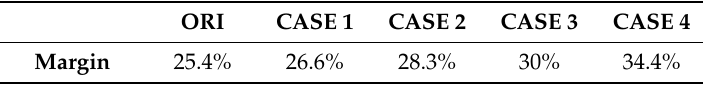
Table 3. The compressor surge margin for all the